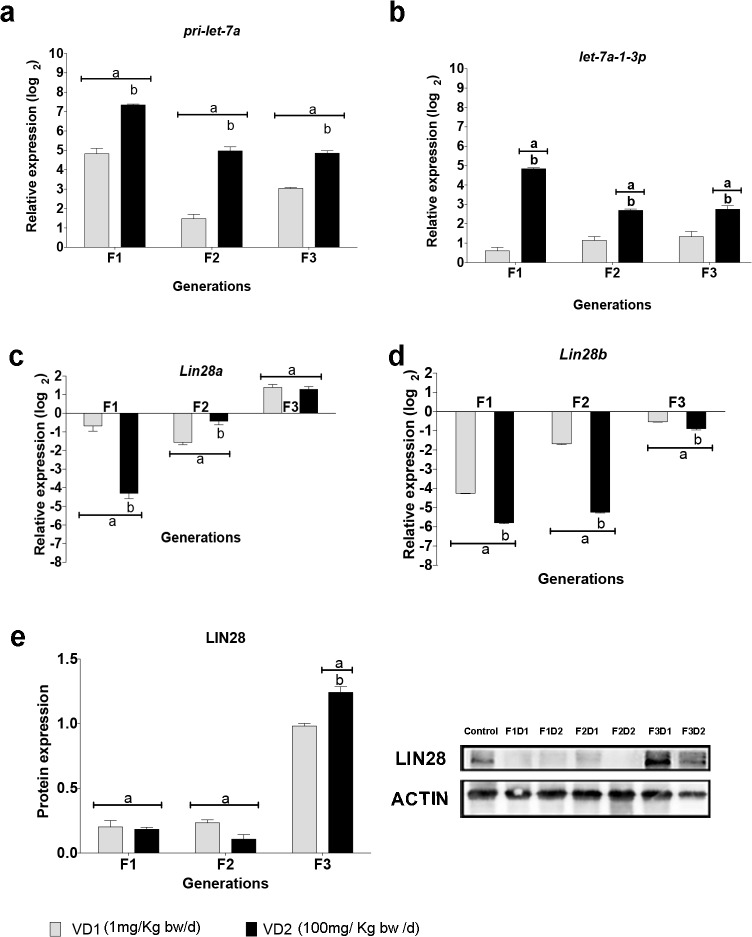
Expression of pri-let-7a, let-7a-1-3p and Lin28 in PGCs of mice exposed to VCZ.a-d) The graphs show the log2 of the fold change of expression in PGCs of exposed embryos relative to the unexposed control embryos. e) LIN28 protein levels measured by Western blot in 13.5 dpc PGCs. The graph bars show the quantification of protein levels normalized to the unexposed control (value = 1). In the graphs the error bars represent the standard deviation (SD), (a) indicates a significant statistical difference of VD1 and VD2 compared to the control (p≤0.01), (b) indicates a significant statistical difference of VD1 compared to VD2 (p≤0.01).